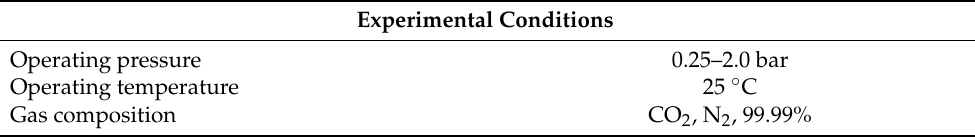
Table 3. Experimental conditions for single gas